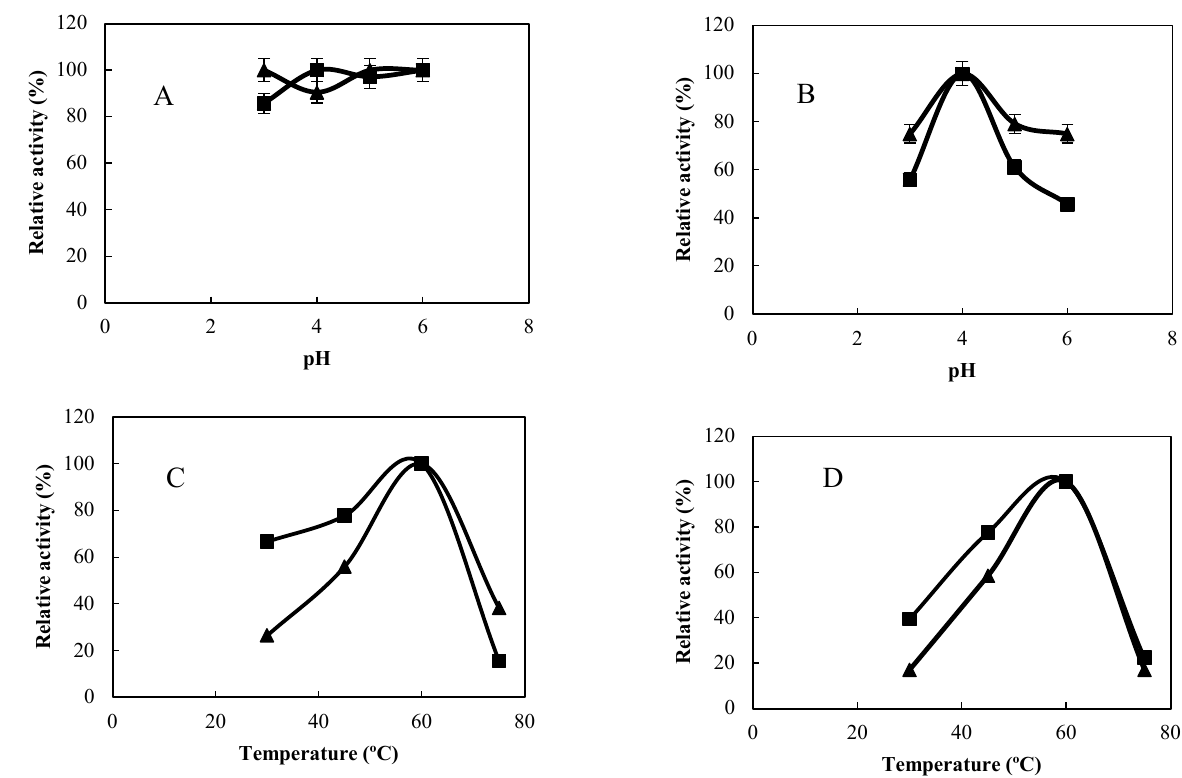
Figure 5. Effect of ( A , B ) pH and ( C , D ) temperature on the initial reaction rate of enzymes immobilized in BGA ( A , C ) and OGA ( B , D ) using ∎ p NPG and ⯅ p NPR.